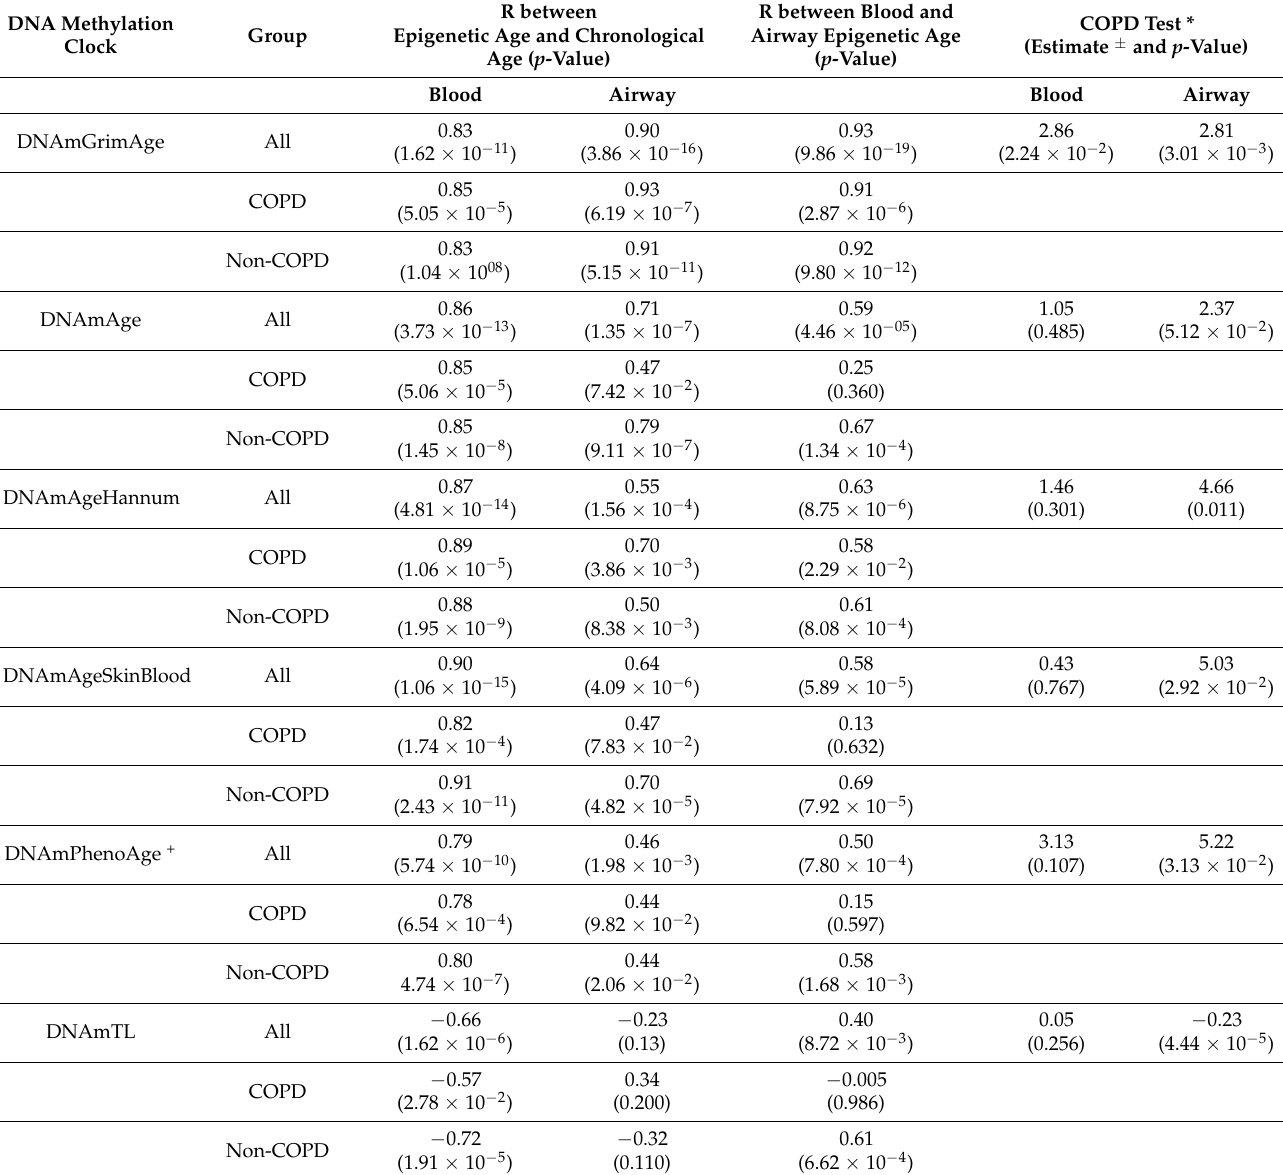
Table 1. DNA methylation age Pearson correlations between blood and airway